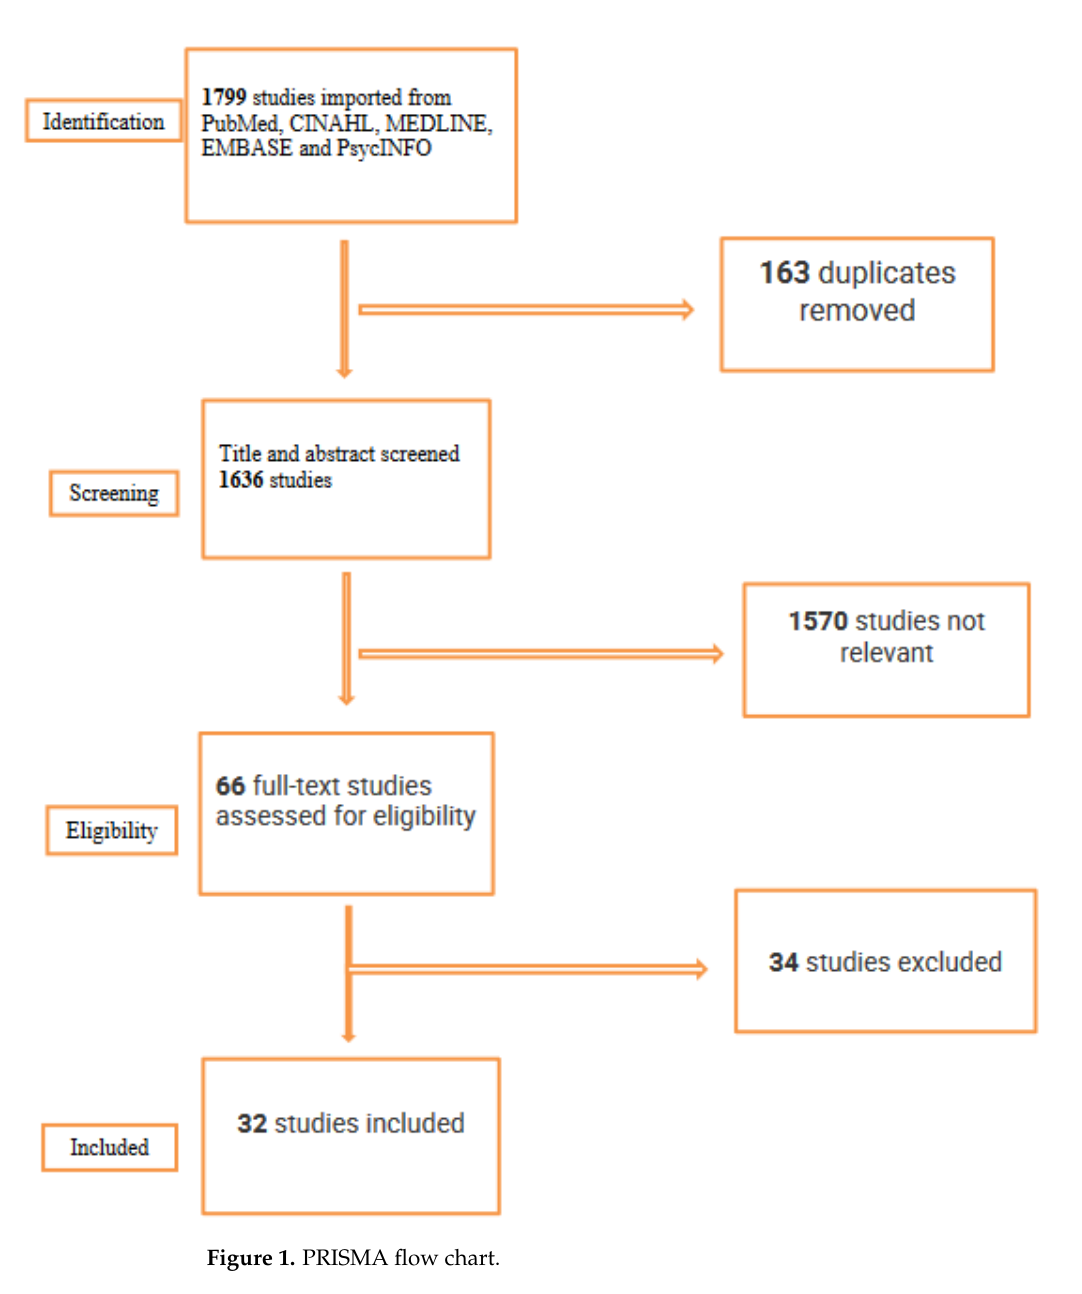
Figure 1. PRISMA flow chart.